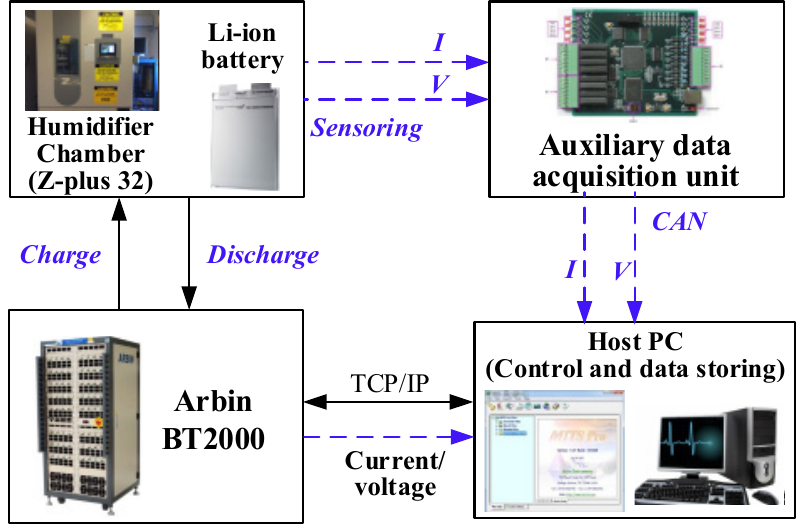
Figure 3. Schematic of the battery test